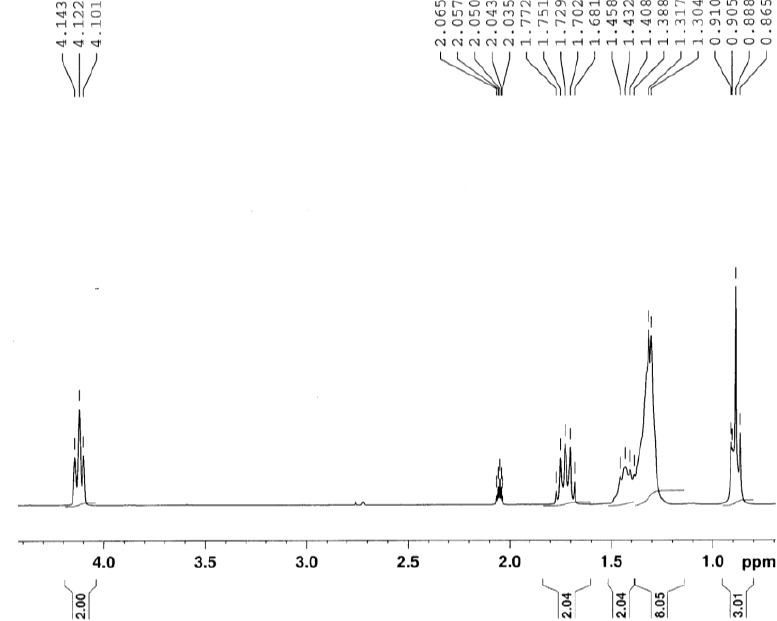
Figure S1. 1 H NMR of C8-PFTE at 300 MHz. d6-Acetone-d6 set at 2.05 ppm is the reference.